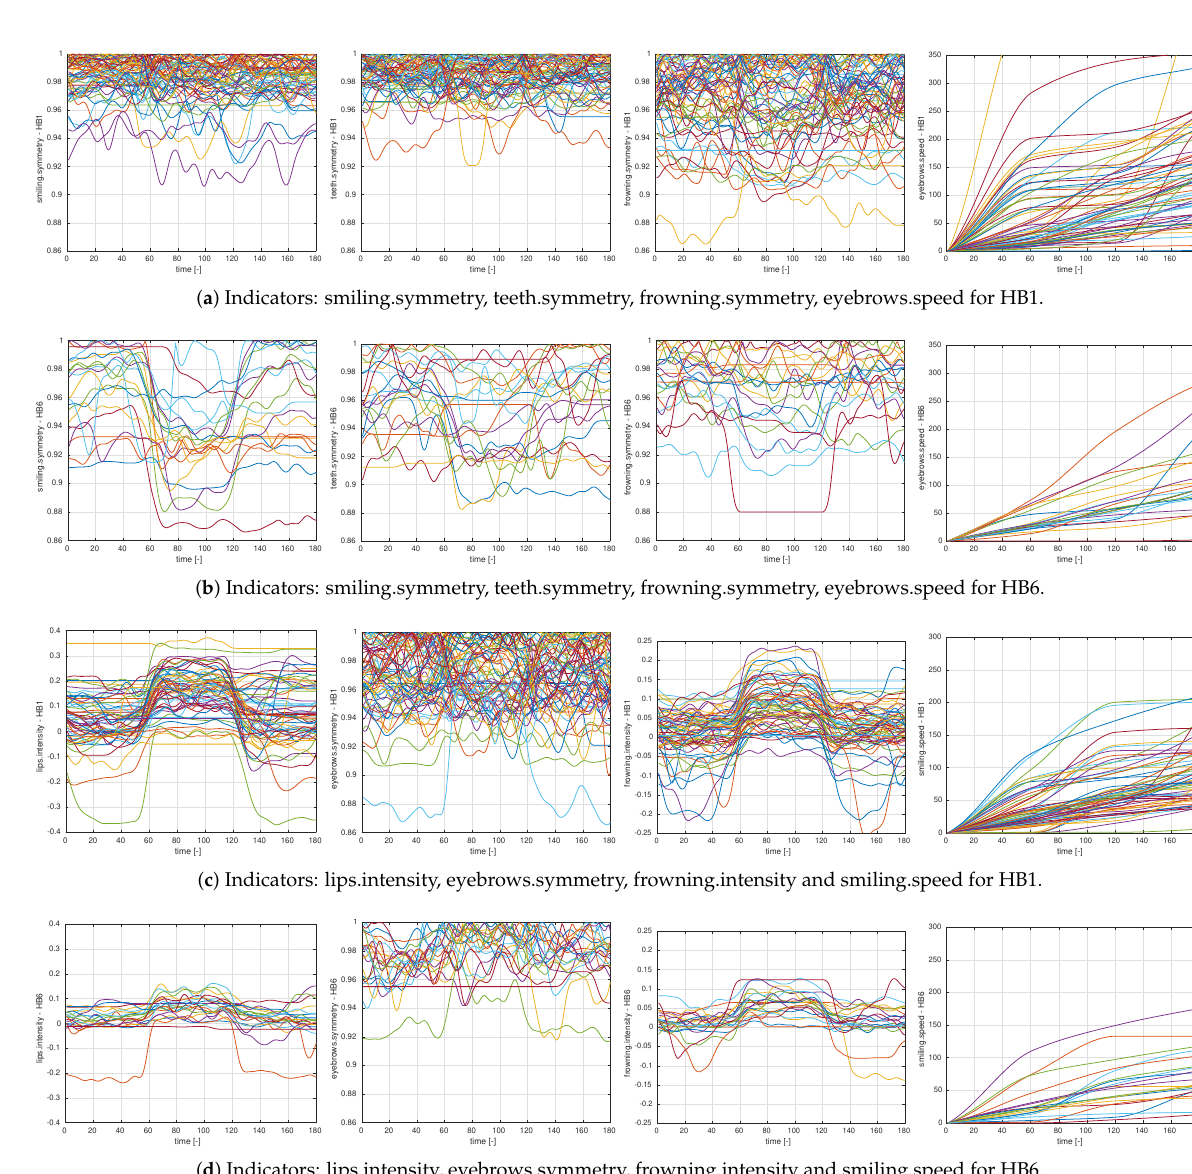
Indicator of symmetry is computed by comparing the left and right distances of two points using the formula